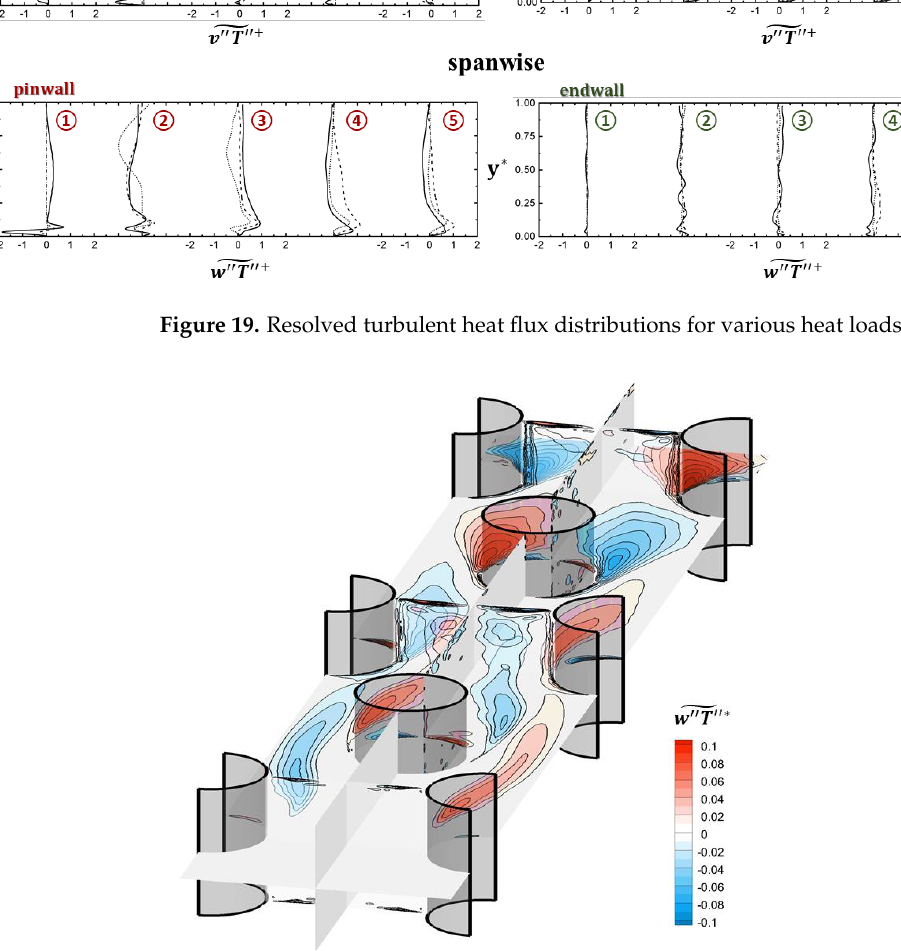
Figure 20. Resolved −𝑤 ′′ 𝑇 ′′ ̃